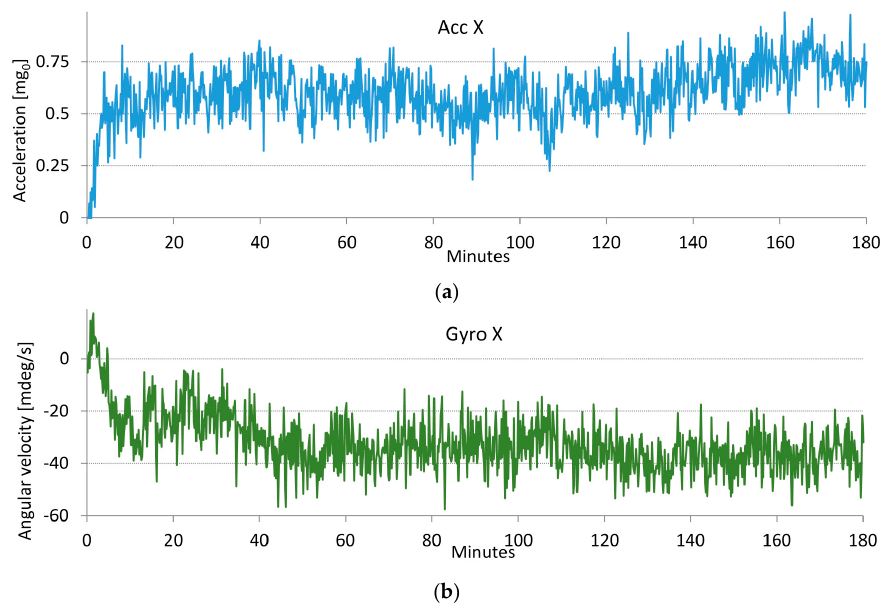
Figure 3. Measured bias values in the 3-hour temperature stress test. The bias values are found by averaging 600 sensor signal samples in 10 s intervals. Temperature changes induce noticeable bias drifts in the accelerometers and gyroscopes. The graphs show the bias drifts of the ( a ) accelerometer X-axis and ( b ) gyroscope X-axis.